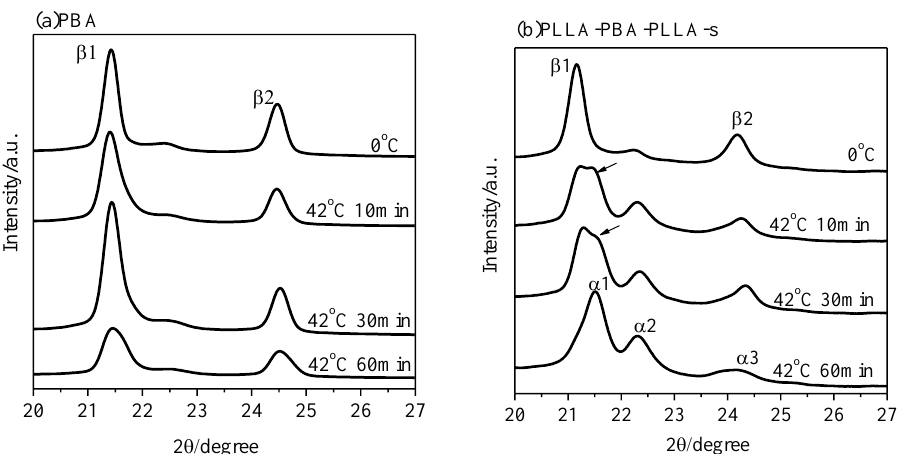
Figure 9. WAXD patterns of ( a ) PBA and ( b ) PLLA-PBA-PLLA-s after initial melt crystallization at 0 °C followed by annealing at 42 °C for different periods of time. (PLLA was held in its amor- phous state).